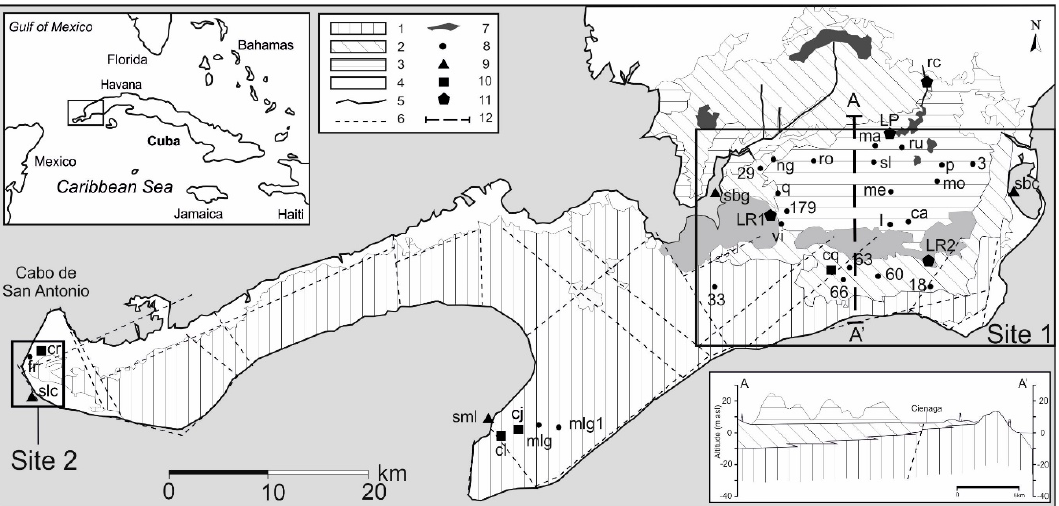
Figure 1. Geological map of the study area. Legend: 1. carbonate formations (Vedado, Jaimanitas, Cayo Piedra); 2. silicoclastic formation (Guane); 3. alluvial deposit; 4. biogenic or undifferentiated deposit; 5. river; 6. fault; 7. lake; 8. monitoring well; 9. seawater sampling point; 10. groundwater sampling in karst cave; 11. water sampling in river, lagoon and cienaga.